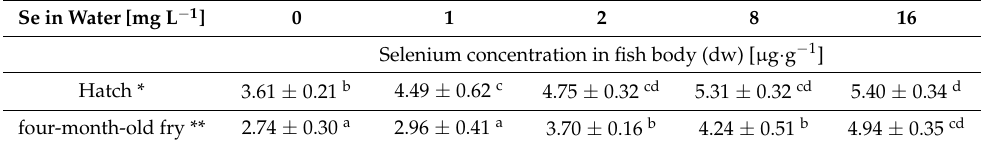
Table 1. Selenium content in sea trout ( Salmo trutta m . trutta ) hatch and fry growing from eggs exposed to different concentrations of inorganic selenium (SeO 2 ) in water during egg swelling.